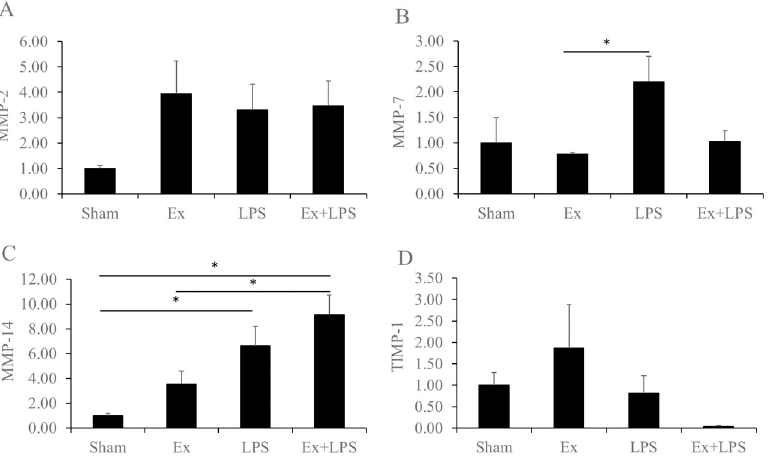
Fig 2. mRNA expression levels of the matrix metalloproteinases and tissue inhibitors of metalloproteinases. Data are presented as fold change. A) MMP-2, B) MMP-7, C) MMP-14, and D) TIMP-1. � Statistically significant.